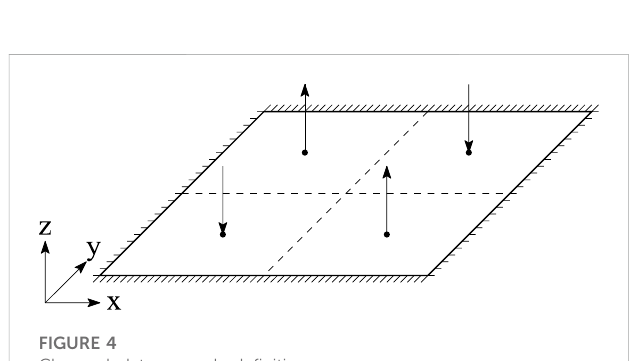
FIGURE 3 Computational grid.